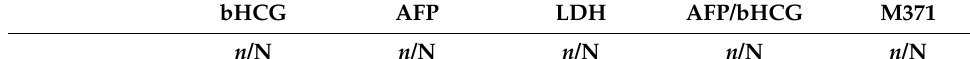
Table 13. Expression rates of serum tumour markers stratified by tumour size